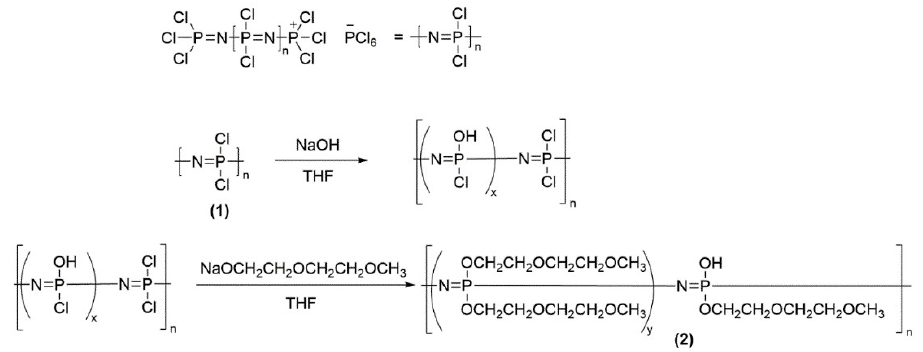
Figure 1. Synthesis of poly[bis 2-(2-methoxyethoxy)ethoxy- co -hydroxophosphazene] ( 2 ).